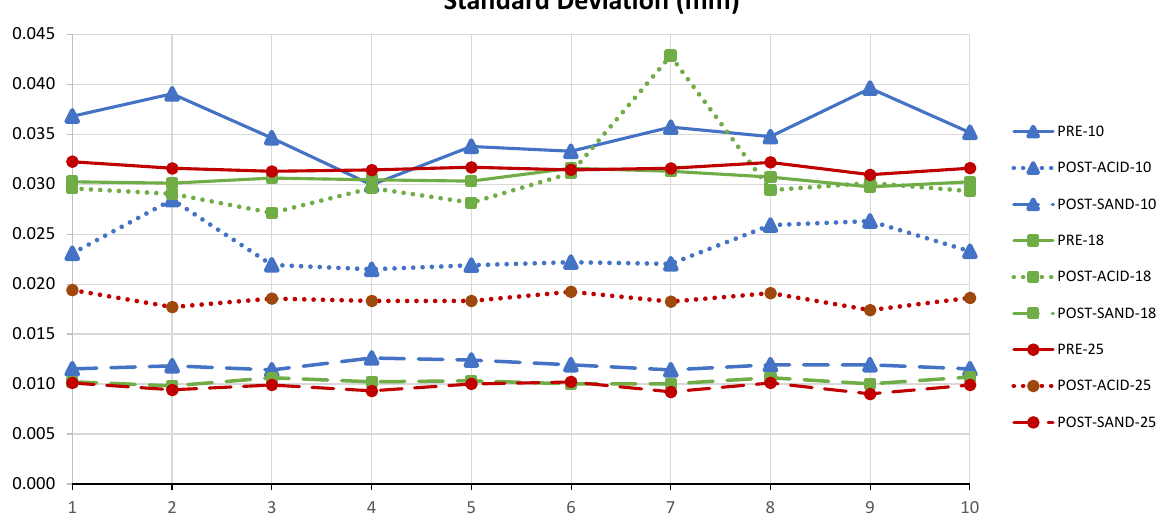
Figure 11. Standard deviation values pre and post sandblasting and acid bath.